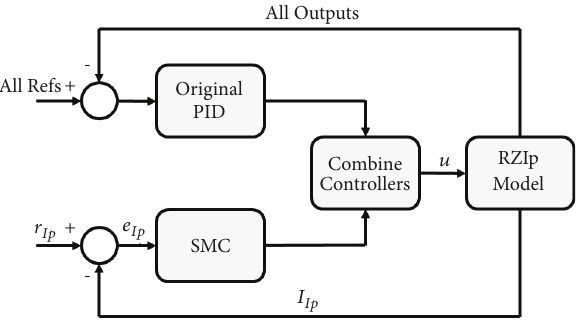
Figure 5: General overview of the